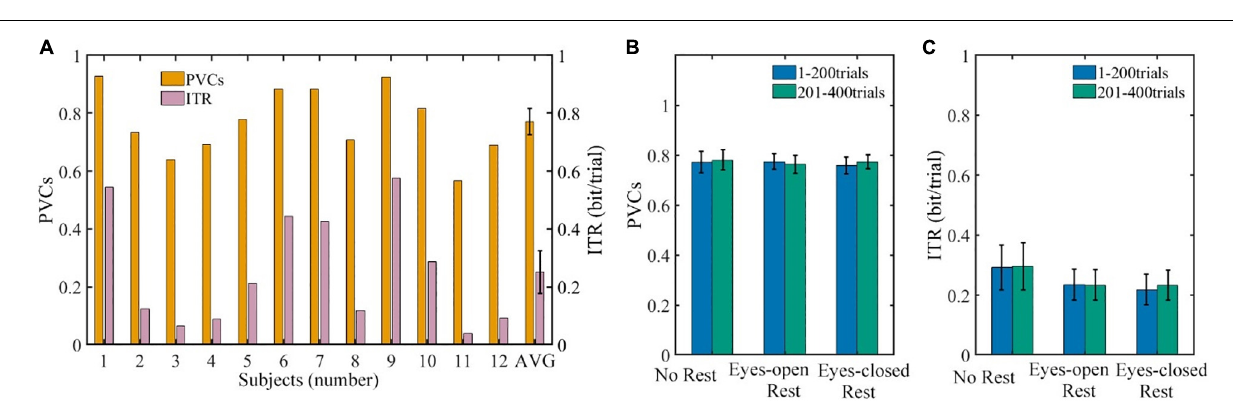
FIGURE 4 | The BCI performances. (A) The performances of each subject (numbered) and average performance of all the subjects (AVG). (B) The PVCs of 1–200 trials compared with 201–400 trials for all the subjects. (C) The ITR per trial of 1–200 trials compared with 201–400 trials for all the subjects. Error bars indicate the SEM. BCI, brain–computer interface; PVC, percent valid correct; ITR, information transfer rate; SEM, standard error of